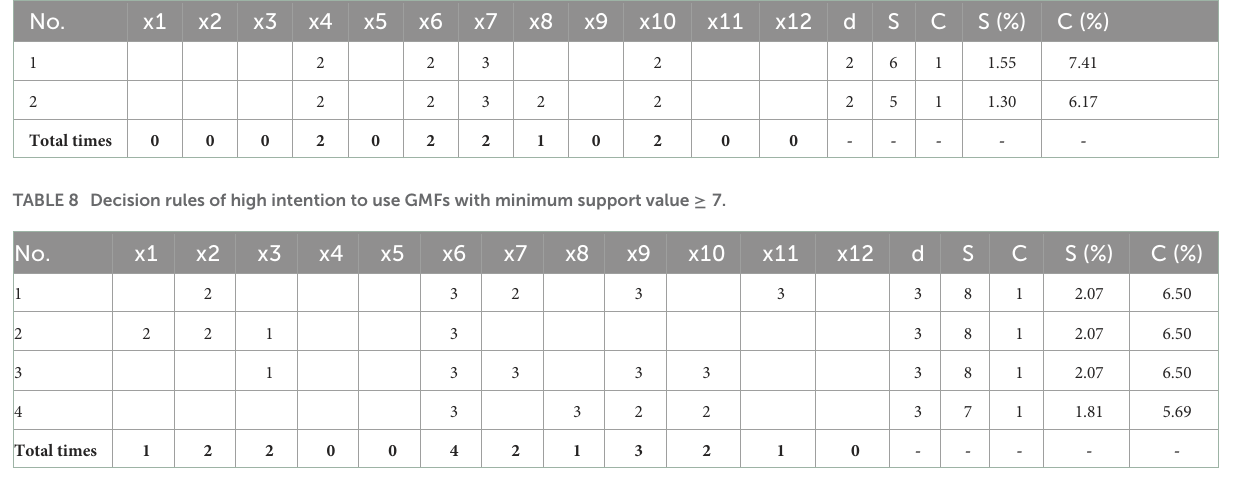
TABLE 9 Top-3 ranking of the variables in three decision classes based on frequencies and percentages. Low Medium High CSR (x6), concerns (x7) (five times,